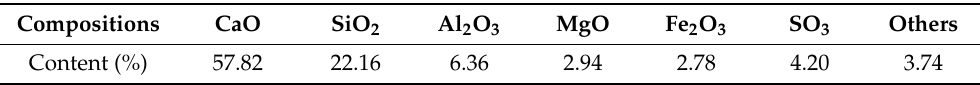
Table 1. Chemical compositions of OPC